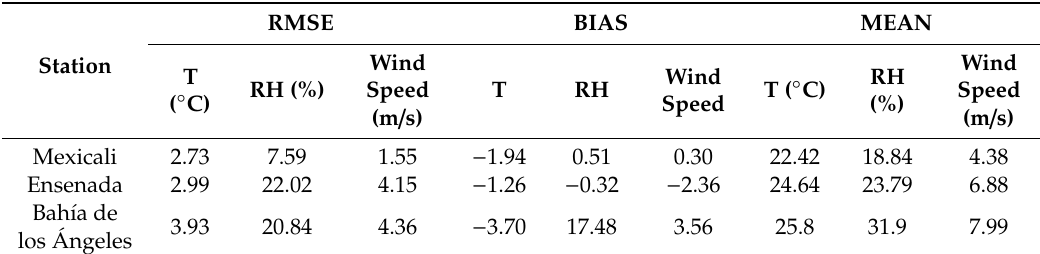
Table 2. Root Mean Square Error (RMSE) and bias calculated from WRF-Chem simulations and stations data along with the mean of observed data for meteorological variables: Temperature (T), Relative Humidity (RH) and Wind